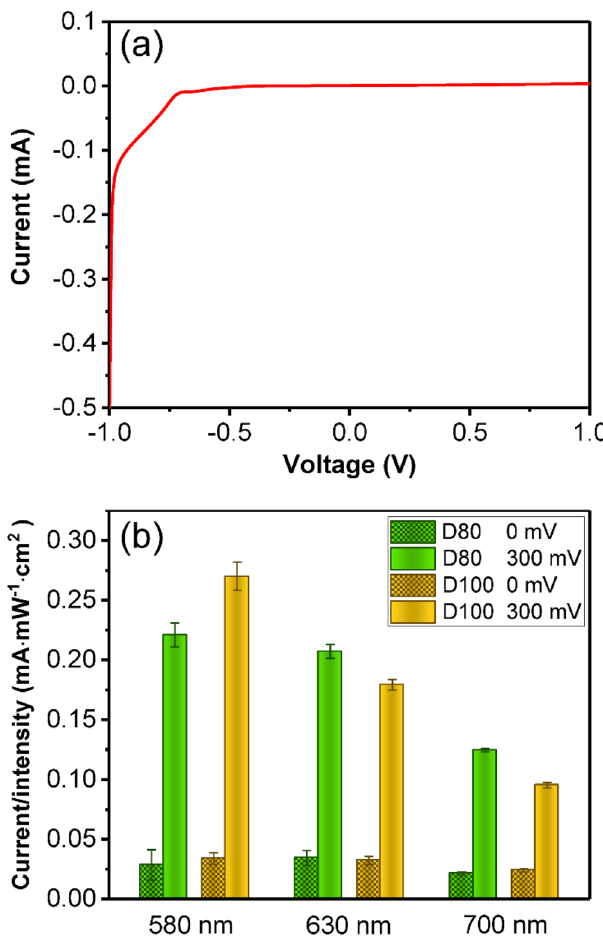
Figure 2. ( a ) I–V curve of AT with 80 nm nanodisk diameter. ( b ) Ratio of photocurrent and light intensity for AT samples with 80 nm and 100 nm nanodisk diameters at bias voltages of 0 mV and 300 mV, and at excitation wavelength of 580, 630 and 700